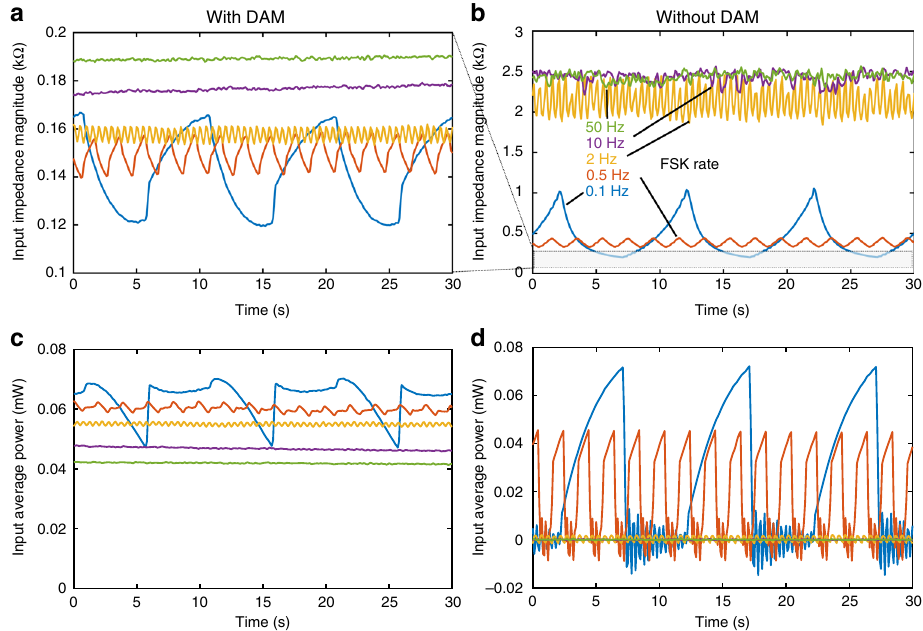
Fig. 7 Effect of frequency shift keying (FSK) rate on input impedance and power. Measured time varying impedance ( a , b ) and input power ( c , d ) for without direct antenna modulation (DAM) ( a , c ) versus with DAM ( b , d ). Various FSK rates are shown. As the FSK rate increases, the input power goes to zero for the without DAM case as the crystal does not build up to full resonance at either frequency. The impedance slightly increases for the DAM case versus increasing FSK rate, and the input average power slightly decreases. However, the change in both is <50%, consistent with the high measured velocity versus FSK rate shown in Fig. 6